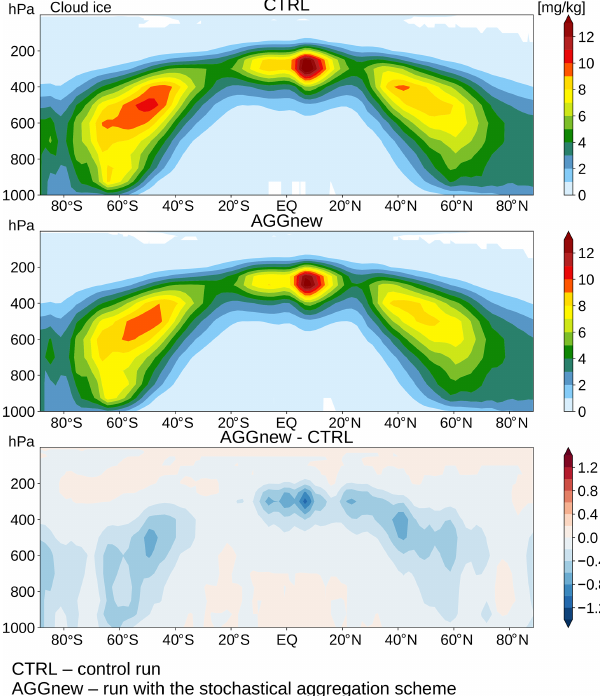
Figure 9. Specific ice water, q i (gkg − 1 ), as zonal, annual mean for (top) standard ICON GCM output, (middle) aggregation parameter- ization revised as stochastic parameterization drawing from the q i subgrid-variability PDF, and (bottom) difference between the